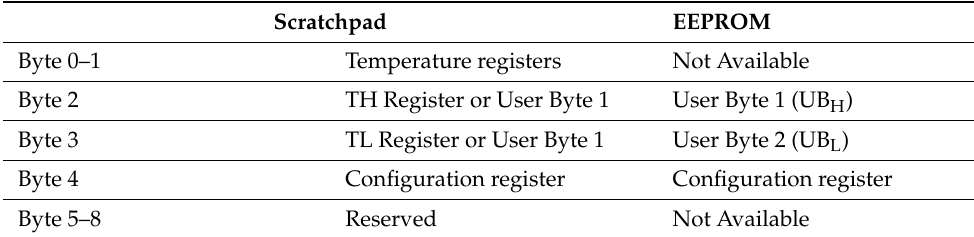
Table 1. Memory map of DS1820 temperature sensor.